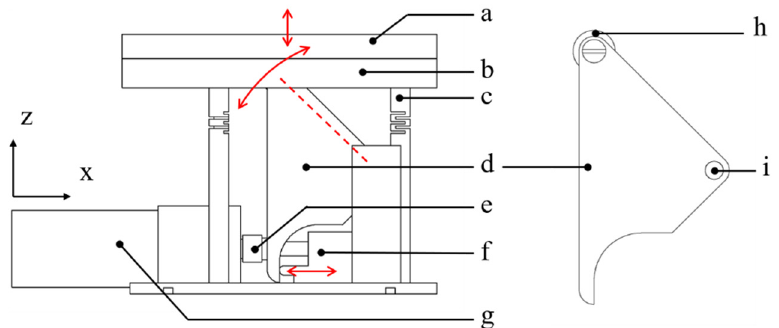
Figure 3. Concept design of the SMFH, consisting of a. Secondary mirror dummy, b. Secondary mirror supporter, c. Flexure hinge, d. Rotation body, e. Motor screw, f. Linear screw, g. Motor, h. Roller, i. Rotation shaft.